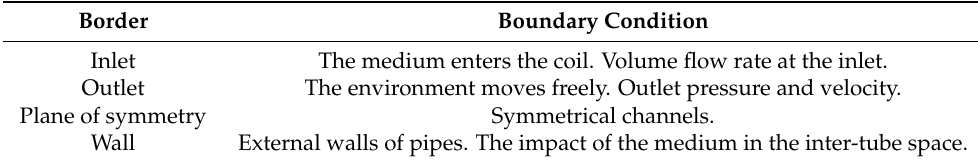
Table 1. Limit conditions.